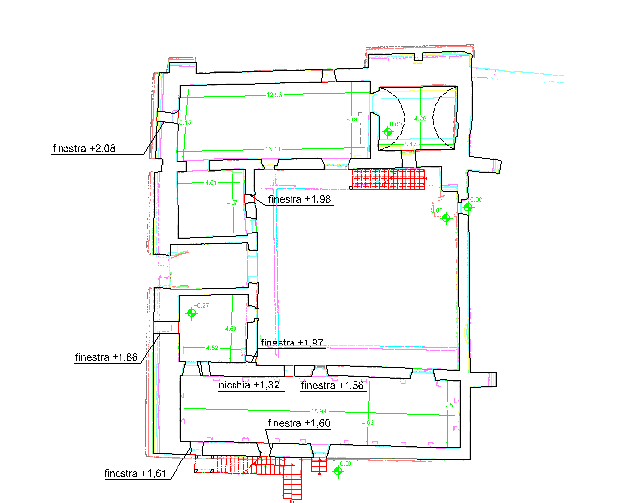
Fig. 10: Plan from point clouds